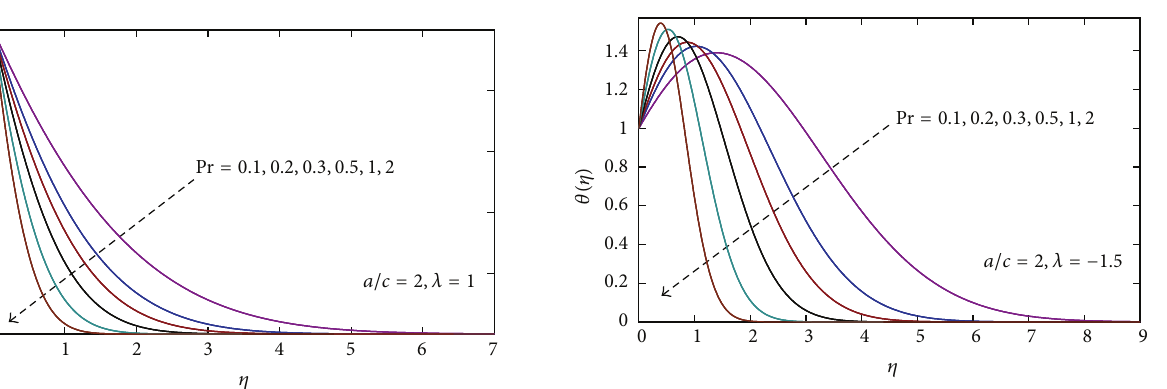
Figure 11: Temperature profiles 𝜃(𝜂) for various values of Pr with 𝑎/𝑐 = 2 and 𝜆 = −1.5 .